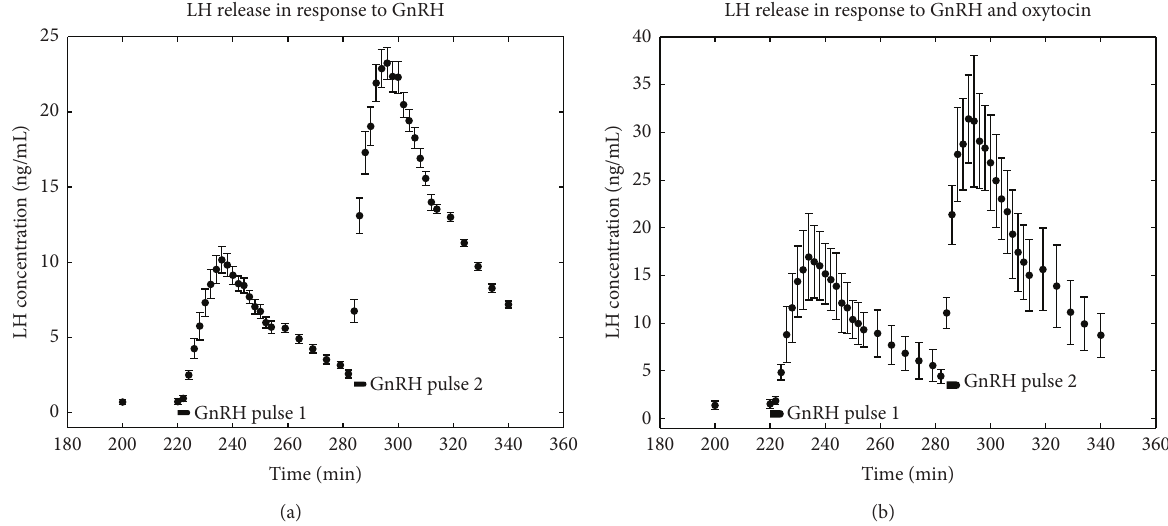
Figure 2: The LH response to two pulses of GnRH by halved hemipituitaries illustrating GnRH self-priming. The black bar shows the onset and duration of the GnRH pulse. (a) LH response to two GnRH pulses. (b) LH response to two GnRH pulses and continuous presence of